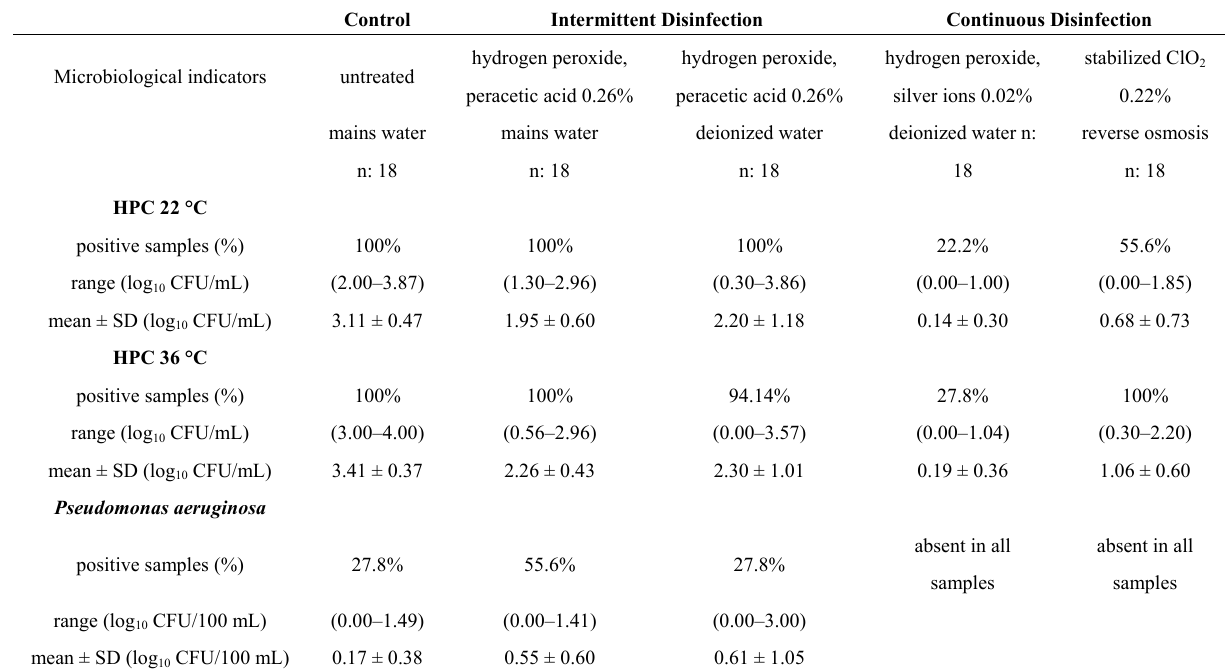
Table 1. Microbial contamination of dental unit